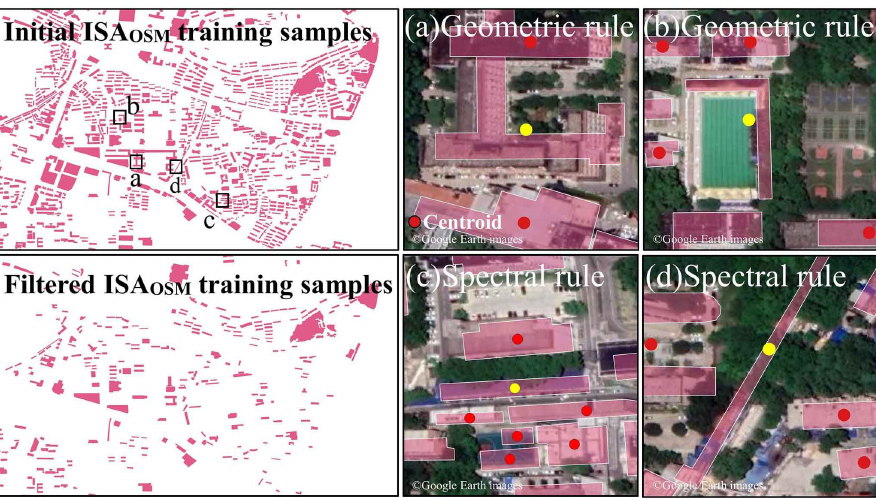
Figure 3. Examples of the initial and filtered ISA OSM training samples from the city of Wuhan in China (30.530202 ◦ N, 114.356287 ◦ E). The yellow points in the close-up maps represent the errors recognized by (a–b) the geometric rule and (c–d) the spectral rule.